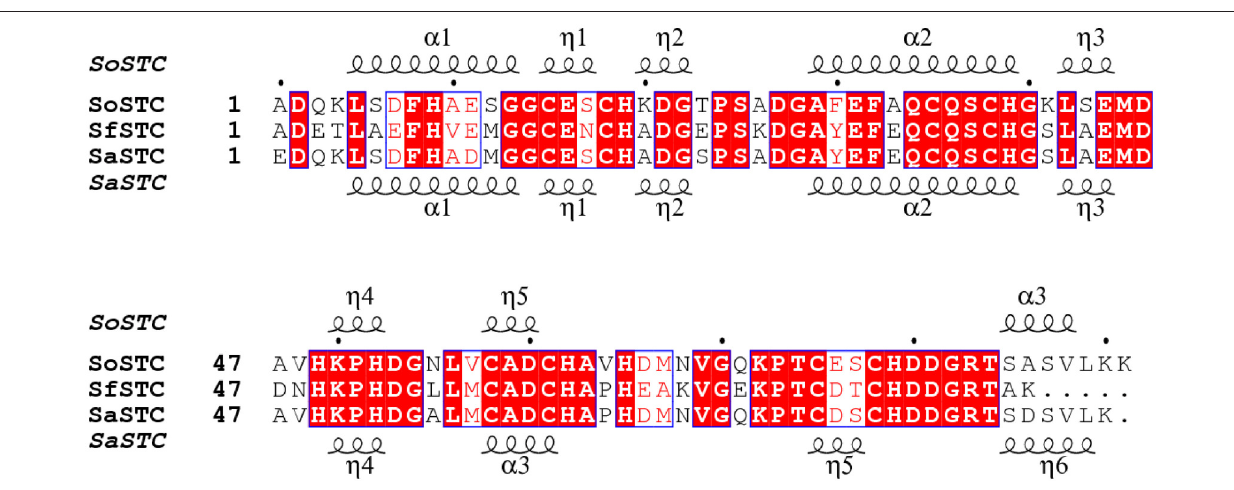
FIGURE 5 | Aminoacid sequence comparison of STC from S. oneidensis , S. frigidimarina, and S. algae . The α and η symbols represent long and short α -helices regions in the three-dimensional structure,